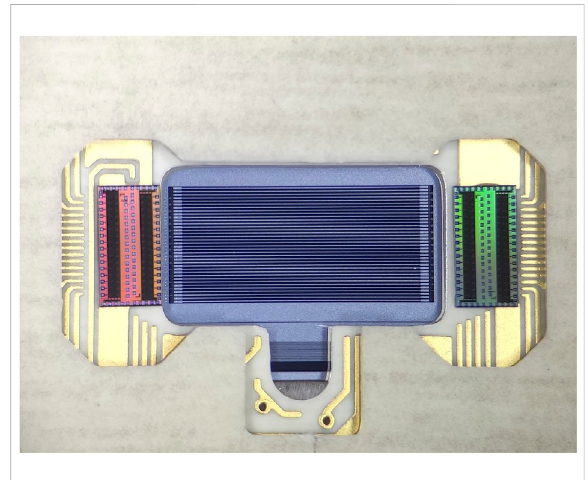
FIGURE 4 Photograph of the 32-channel strip detector with 100 μ